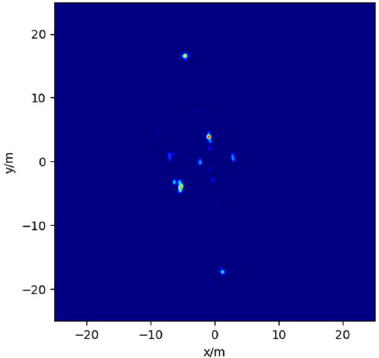
Figure 8. Imaging result of electromagnetic calculation data via MIMO-LI-Net.